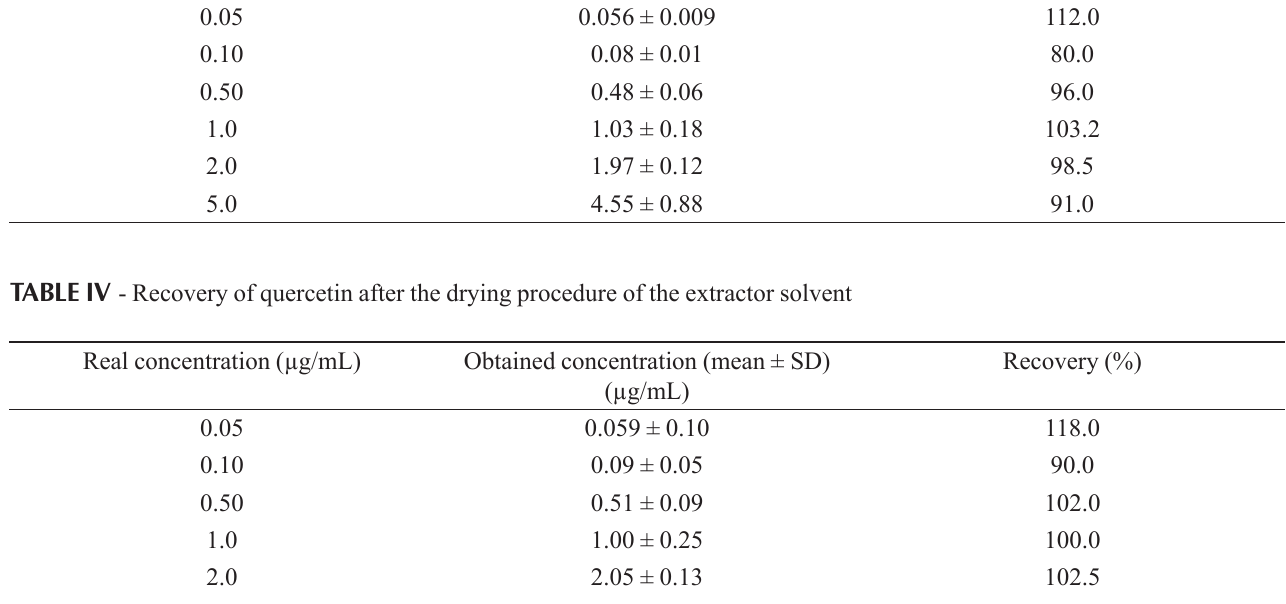
TABLE III - Recovery of the extraction procedure of quercetin from receptor medium (final pH = 4) using dichloromethane as extractor solvent Real concentration (µg/mL)